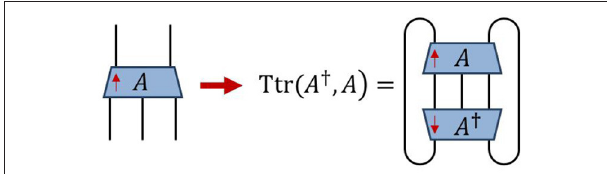
FIGURE 5 | For any tensor A the tensor trace Ttr of A with its conjugate A † (drawn with opposite vertical orientation) is obtained by contracting over all matching indices. The Frobenius norm can be defined as the root of this tensor trace, see Equation (14). is defined as the square-root of the sum of the magnitude of each